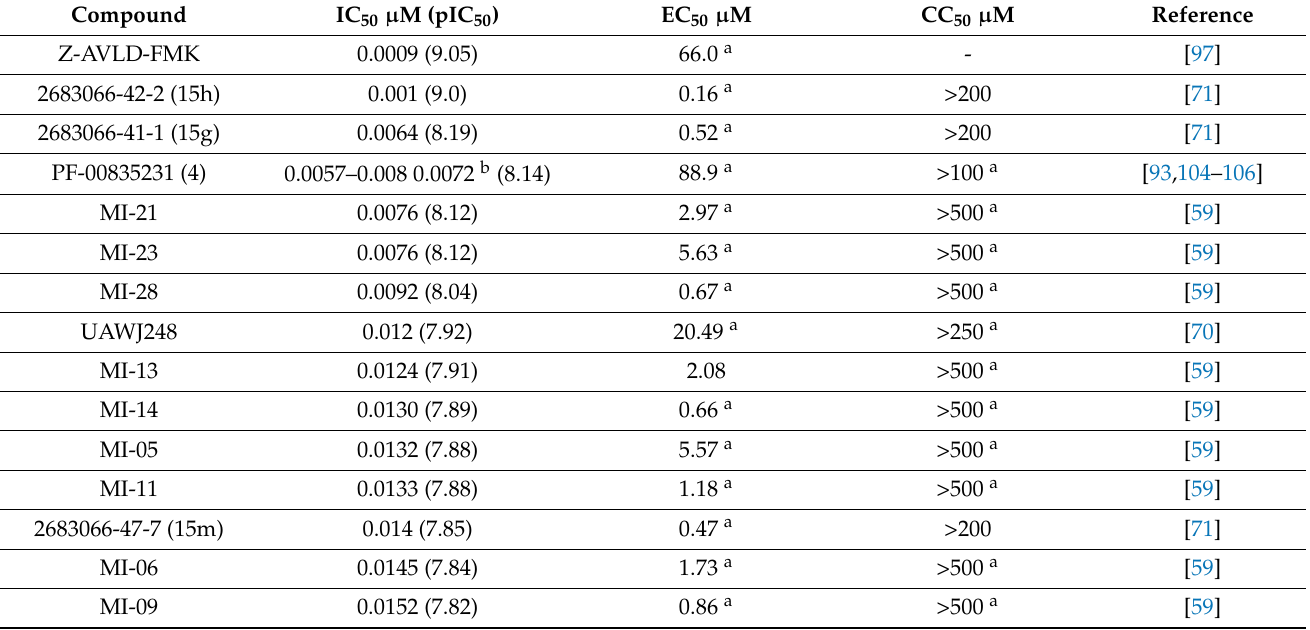
Table 4. Data from the 15 most potent covalent inhibitors of the SARS-CoV-2 M-pro.